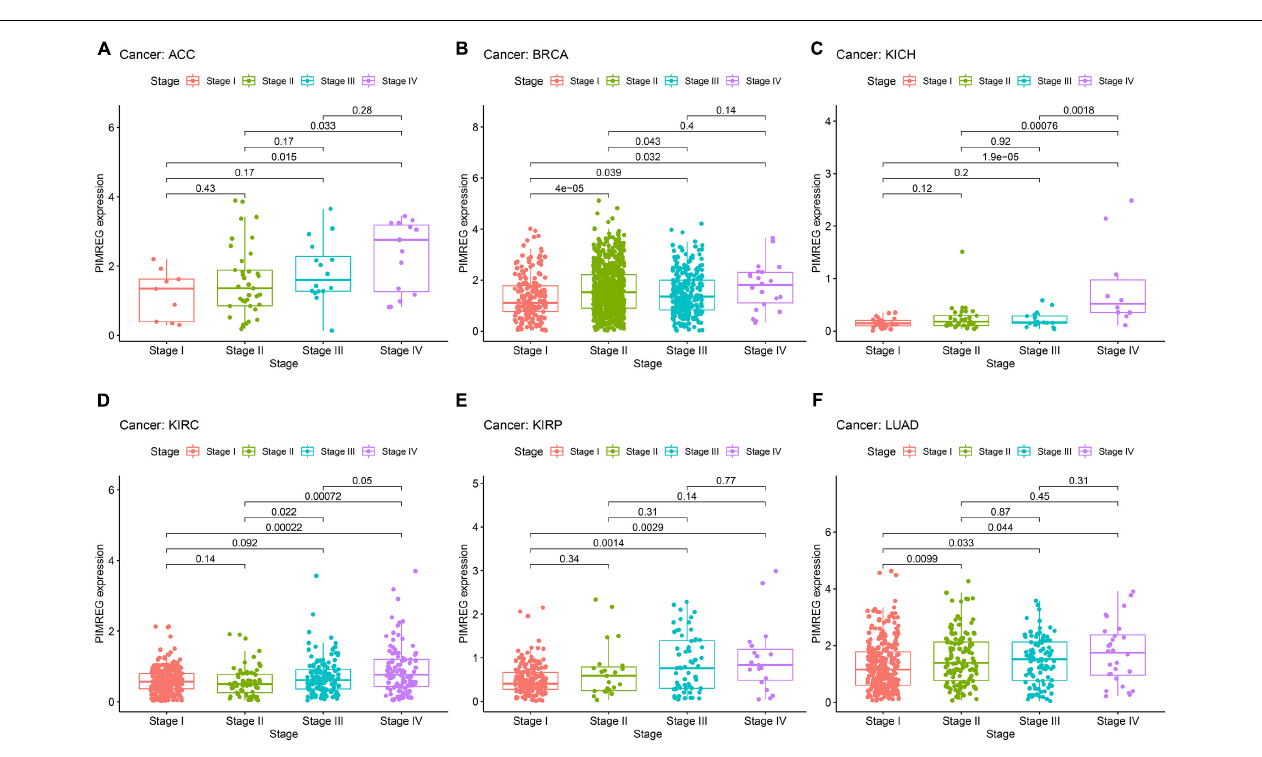
FIGURE 9 | Association between the expression of PIMREG and tumor stage in panel (A) adrenocortical cancer (ACC), (B) breast cancer (BRCA), (C) kidney chromophobe (KICH), (D) kidney clear cell carcinoma (KIRC), (E) kidney papillary cell carcinoma (KIRP), and (F) lung adenocarcinoma